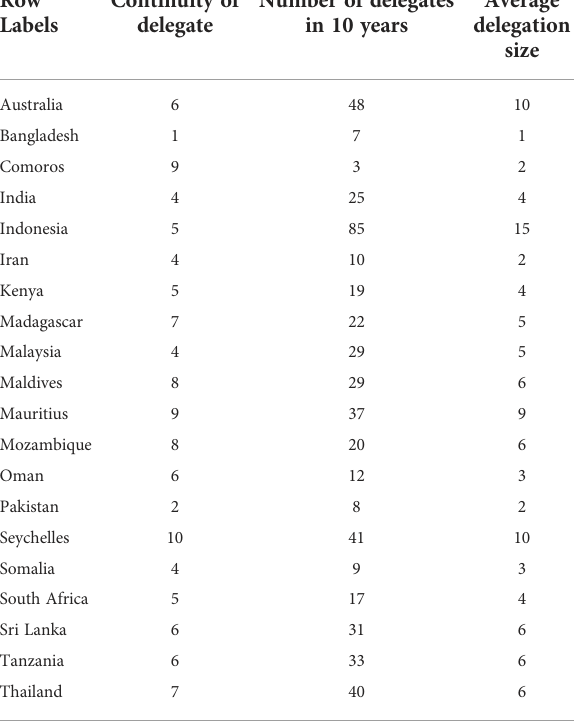
TABLE 2 G16 Members and participation patterns of delegates (number of individual delegates and average delegation size per year) from 2012 -